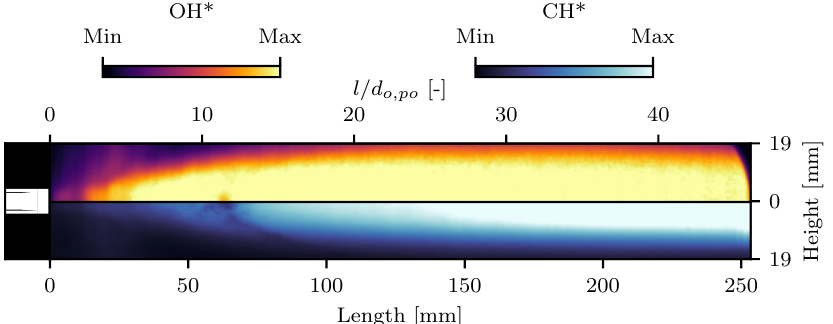
Figure 10. Time-averaged flame radiation imaging (OH*/CH*) of